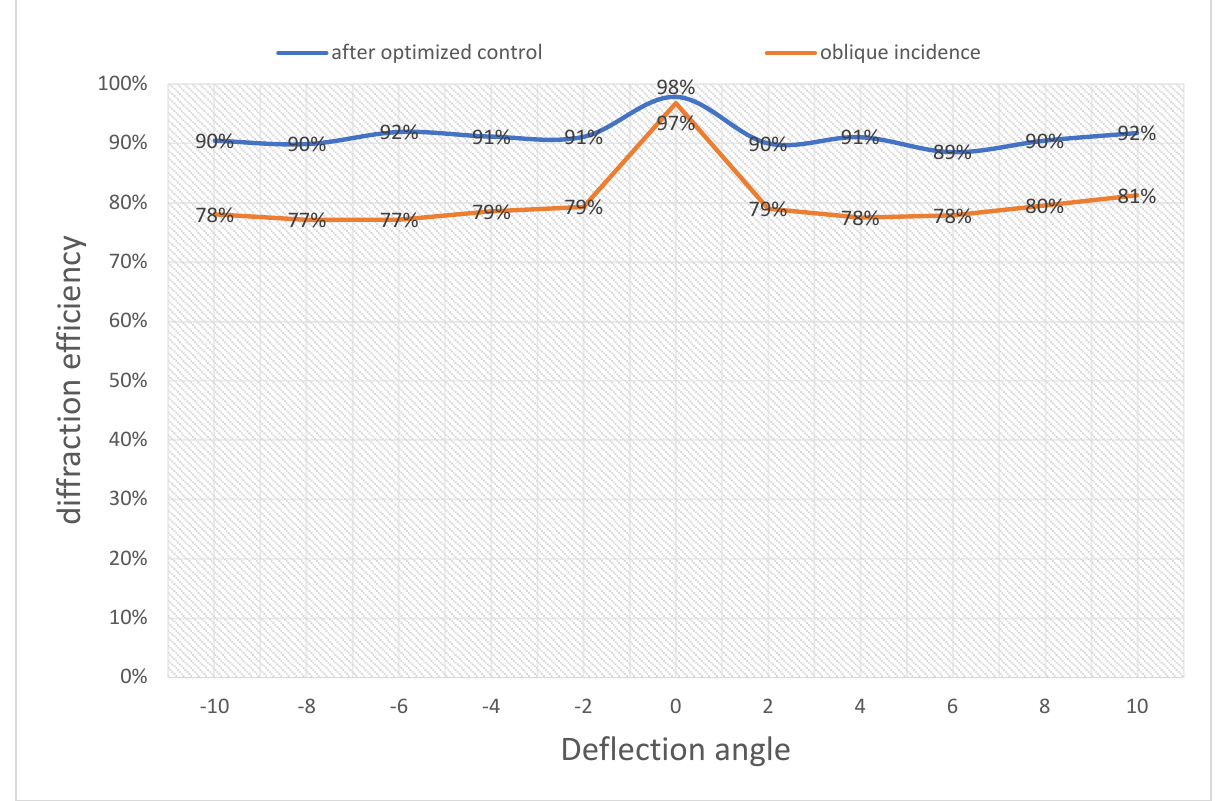
Figure 10. Diffraction efficiency diagram before and after optimization control.